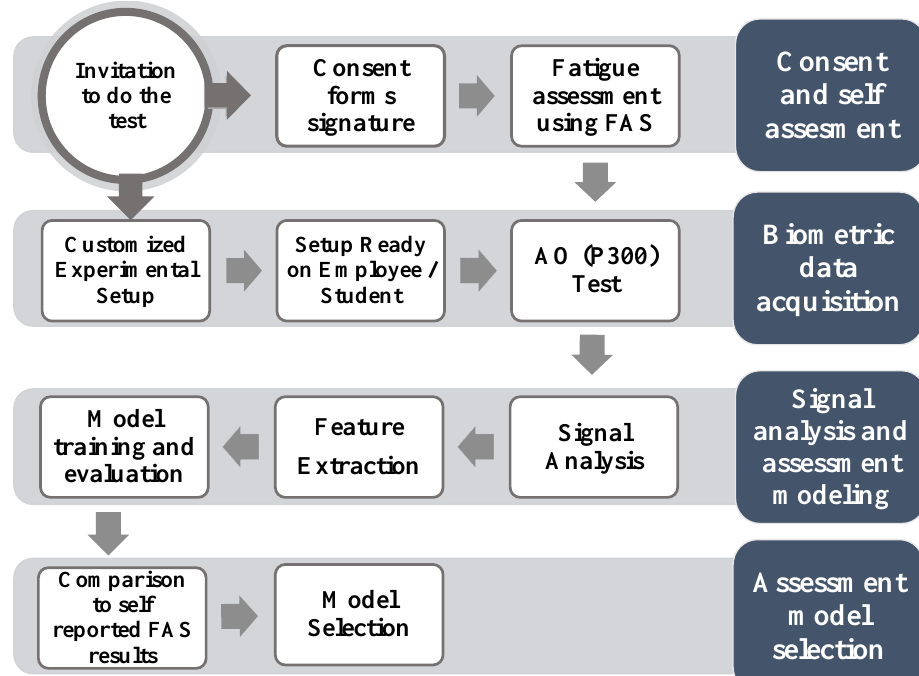
Figure 3. Diagram of the methodology implemented in the study. After data acquisition, the signal processing, feature extraction and model evaluation steps were